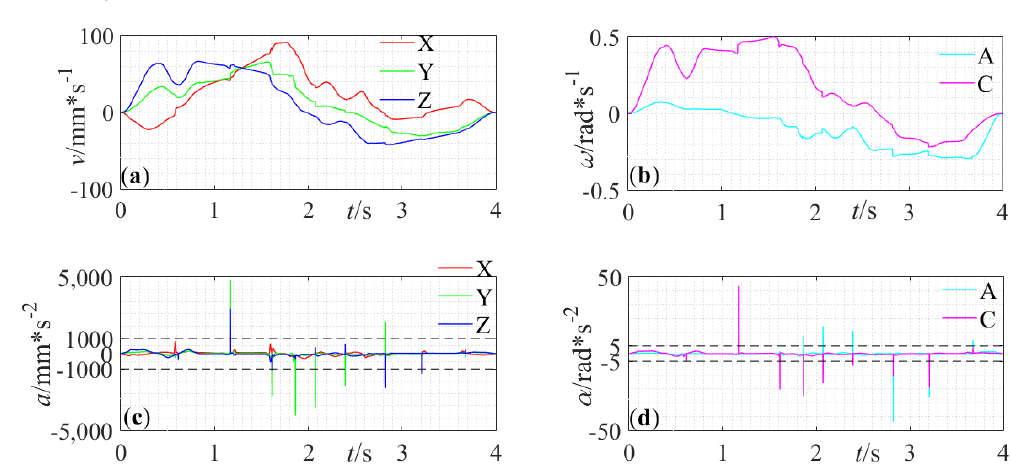
Figure 16. Axial velocities and accelerations that does not consider axial kinematic constraints— ( a ) Translational axial velocities. ( b ) Rotary axial velocities. ( c ) Translational axial accelerations. ( d ) Rotary axial accelerations.